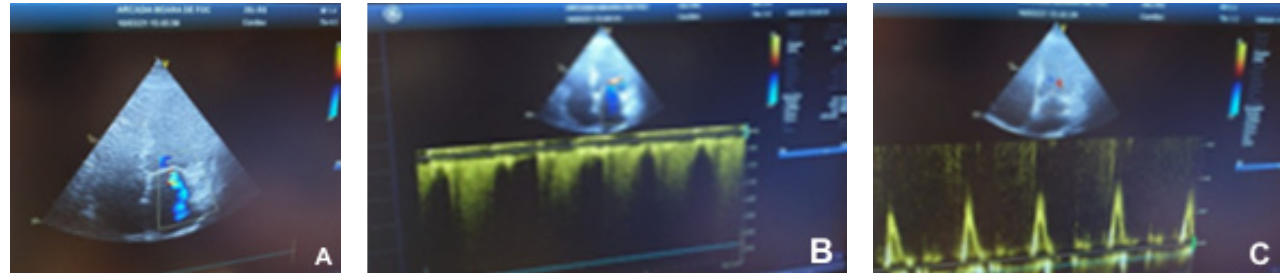
Figure 2. Dilated cardiomyopathy echocardiogram. ( A )—Mild tricuspid regurgitation allowing the measurement of ( B )—right ventricular–right atrial gradient and the estimation of systolic pulmonary artery pressure. ( C )—diminished tricuspid annular plane systolic excursion.